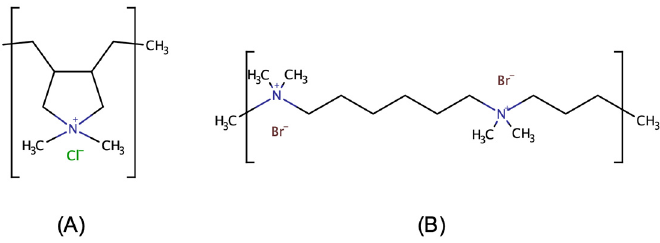
Figure 4. The chemical structures of the applied cationic polymers as coating agents: ( A ) PDADMAC; ( B ) PB.